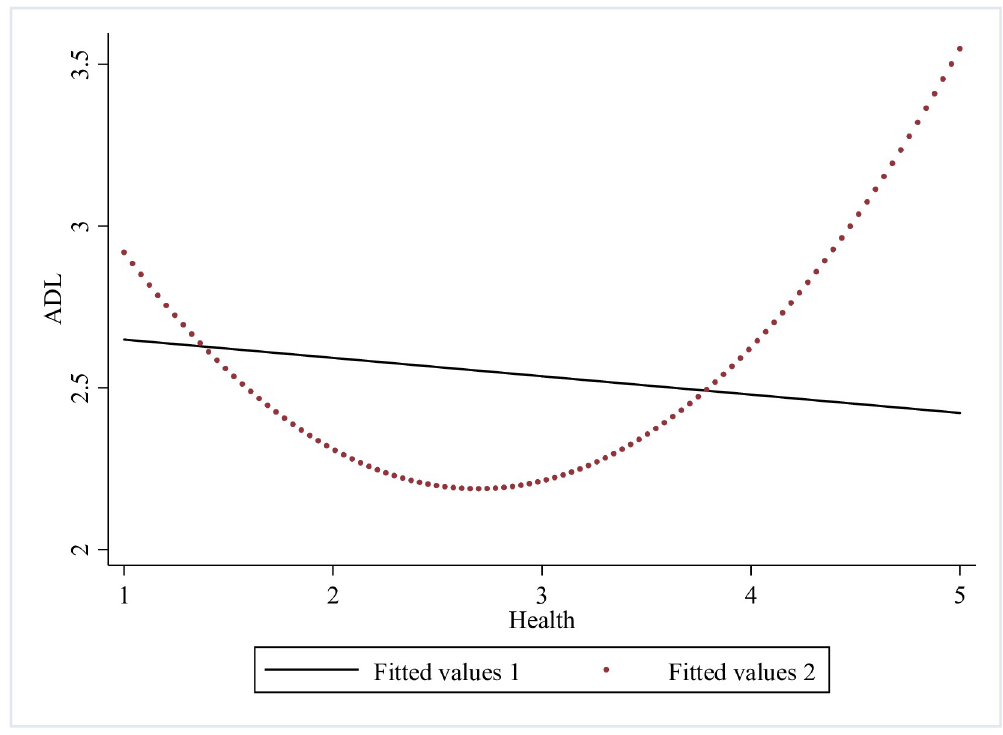
Fig 2. Fit relationship between health and ADL